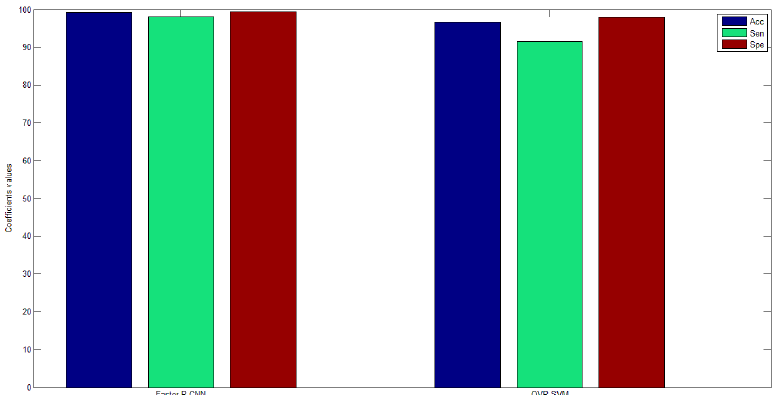
Figure 15. Faster R-CNN and one versus rest support vector machine (OVR SVM) comparison results.